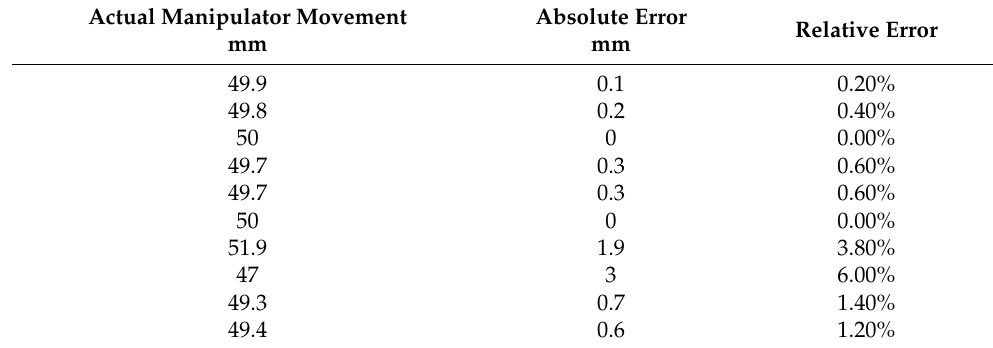
Table 1. Measurements of the manipulator’s z-axis movements for a setpoint of 50 mm.